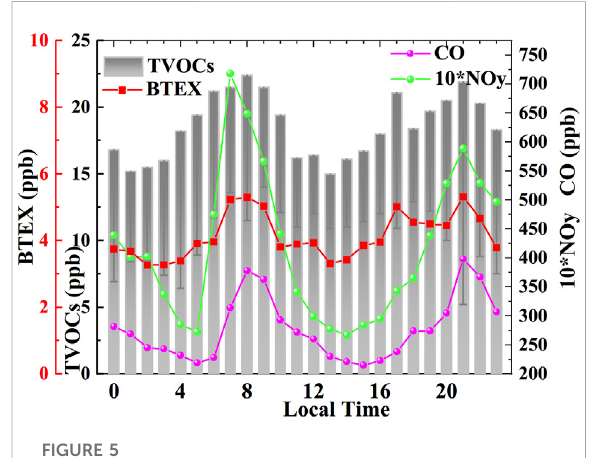
FIGURE 5 Average daily variation in CO, NOy, TVOC, and BTEX mixing ratios (error bar indicates 1 σ ).